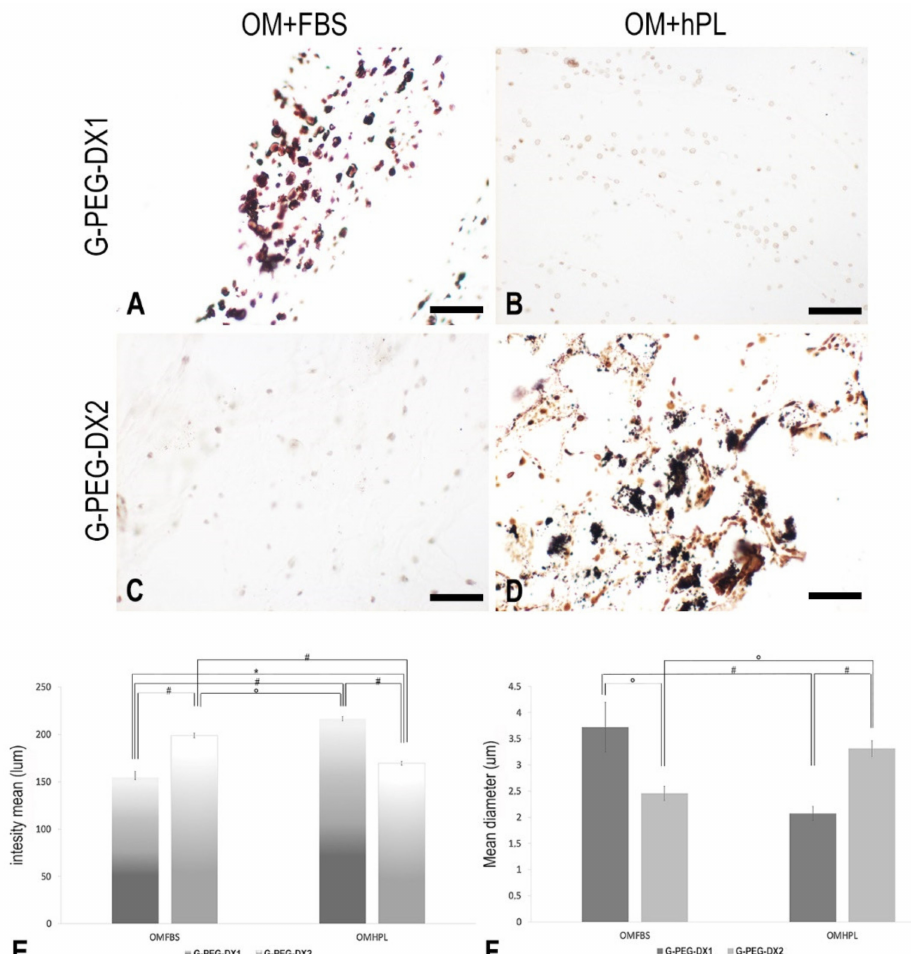
Figure 5. Calcium deposits in hydrogels using Von Kossa stain. Microphotographs of Von Kossa stain at high magnification for diameter and intensity of calcium deposits in hydrogels. Microphotographs of G-PEG-Dx1 ( A , B ) and G-PEG-Dx2 ( C , D ) under the osteoinductive culture conditions: OM+FBS ( A , C ), OM+hPL ( B , D ). Calcium deposits appeared as dots in brown/black color. Scale bar: 20 µ m. Quantification of intensity (luminosity-lum) ( E ) and diameter ( F ) of calcium deposits; ◦ p < 0.05; * p < 0.01; # p <